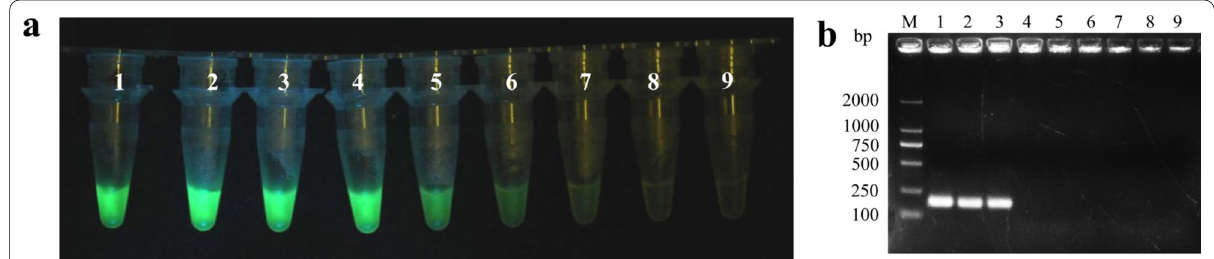
Fig. 5 Sensitivity assay for RT-RAA-CRISPR/Cas12a detection. a The RAA products (amplicons) from tenfold serial dilutions of MCMV cDNA was applied to RT-RAA-CRISPR/Cas12a detection. Tubes 1–8, tenfold serial dilutions (10 0 –10 –7 ) of MCMV cDNA (the reverse transcription reaction was initiated with 2000 ng of total RNA); Tube 9, ddH 2 O as a blank (negative) control. b Results of agarose gel electrophoresis of the PCR products. Lane M, DL2000 DNA marker; Lanes 1–8, PCR amplicon from tenfold serial dilutions (10 0 –10 –7 ) of MCMV cDNA (the same concentration as in a ); Lane 9, ddH 2 O as a negative